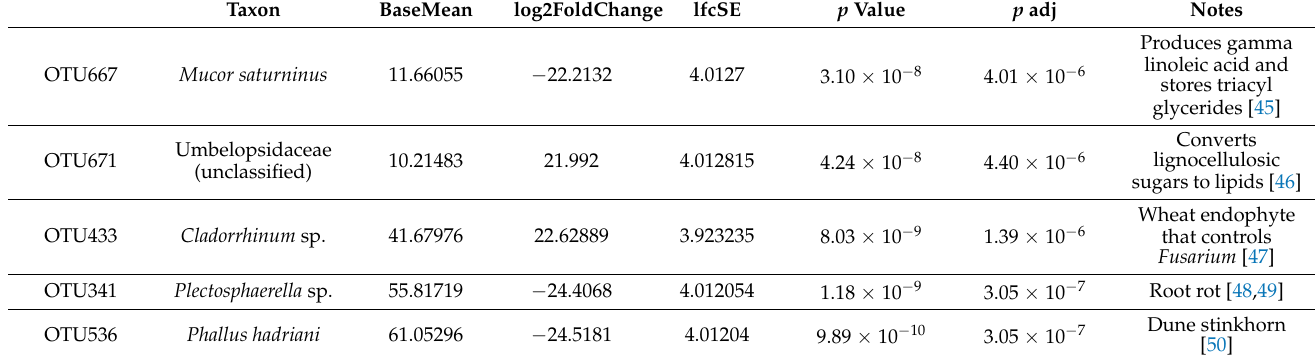
Table 5. DESeq2 results for differentially expressed fungal taxa associated with the Red Trail vs. the Blue trail during winter 2020. Positive log fold change results represent sequences that were differentially abundant on the Red Trail. Negative log fold changes represent sequences that were differentially abundant on the Blue